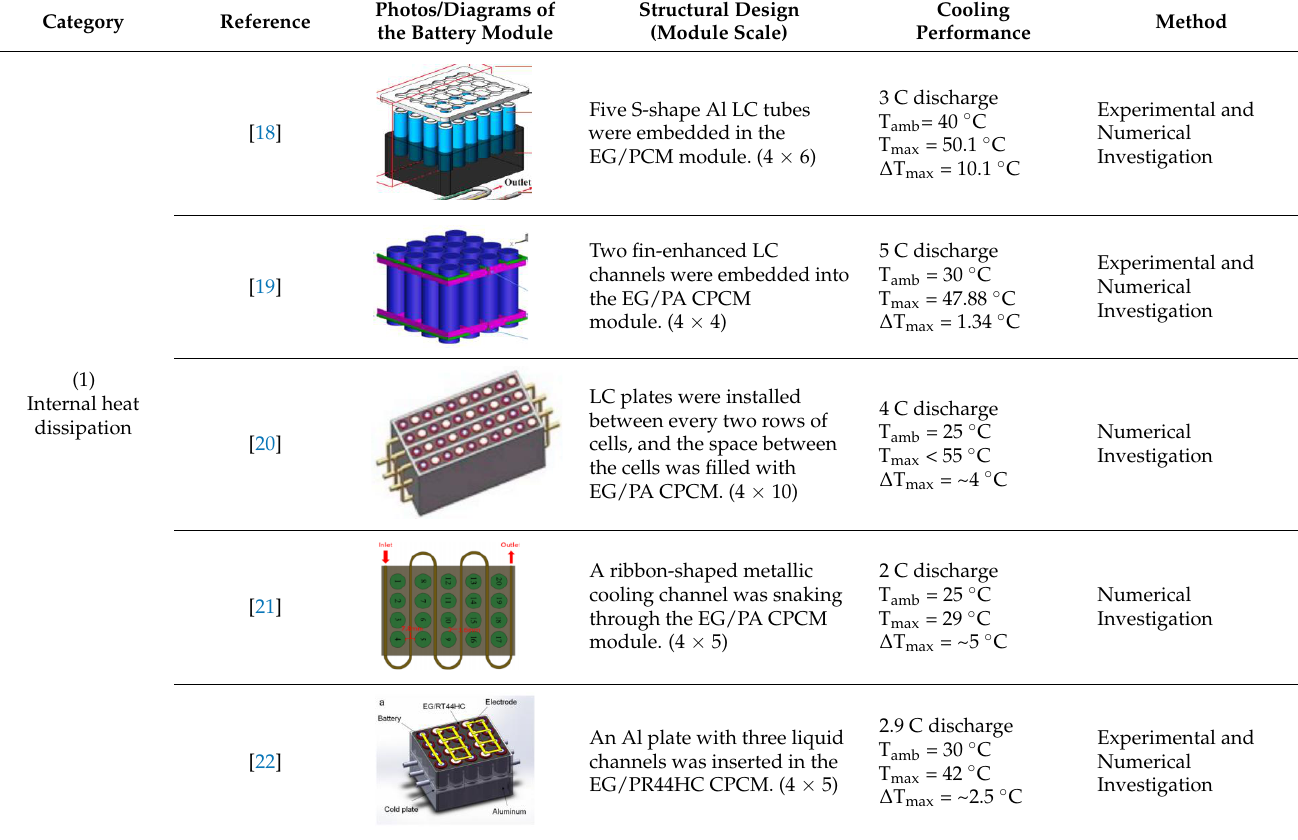
Table 1. Hybrid PCM-LC systems in previous works.